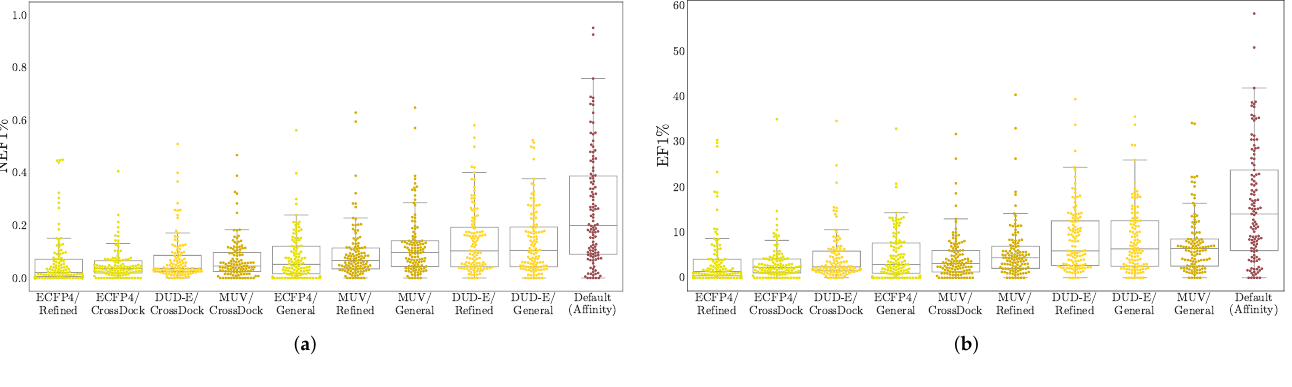
Figure 7. Early enrichment as measured by ( a ) NEF1% and ( b ) EF1% of best-performing ligand-only descriptor models when trained on different descriptors (ECFP4, MUV, DUDE-E—see Table 1) using training sets of different sizes and compositions (Refined and General from the PDBbind [55] and CrossDock2020 [45]). Each dot represents the best performing model for a DUD-E or LIT-PCBA target. Performance of the Default ensemble is provided for